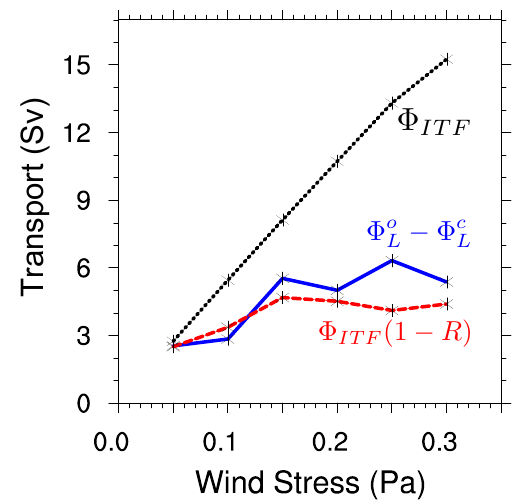
Fig. 10. Comparison of the right hand side and the left hand side of Eq. (4) for the equilibrium solutions of HIM CTRL and HIM